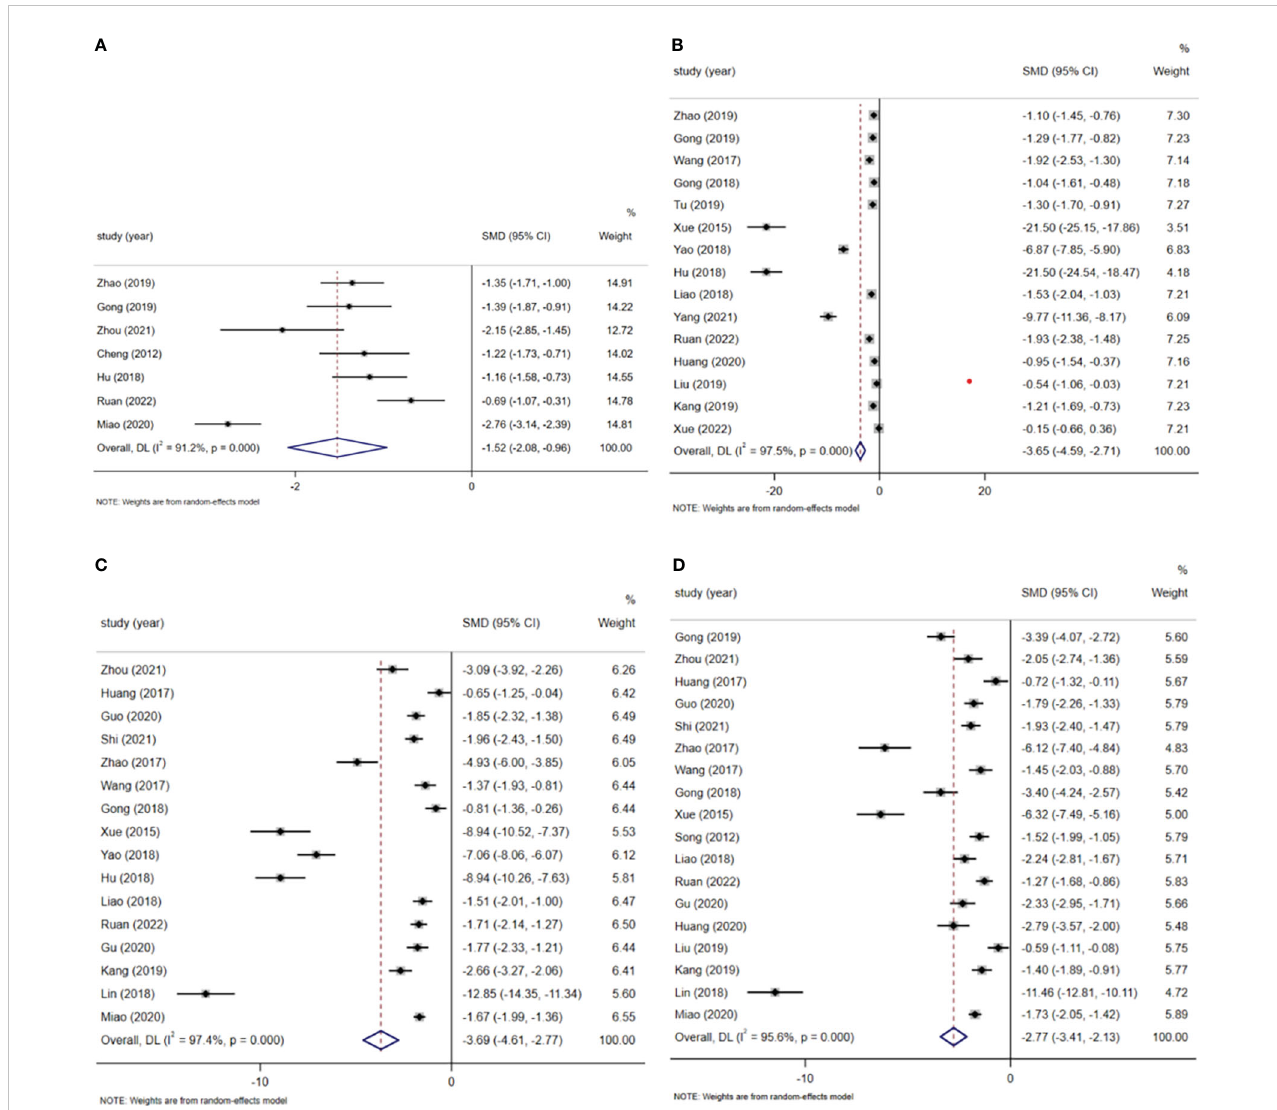
FIGURE 4 (A) Time of fi rst bowel movement after surgery. (B) Time of fi rst postoperative food intake. (C) Removal time of catheter. (D) Removal time of drainage